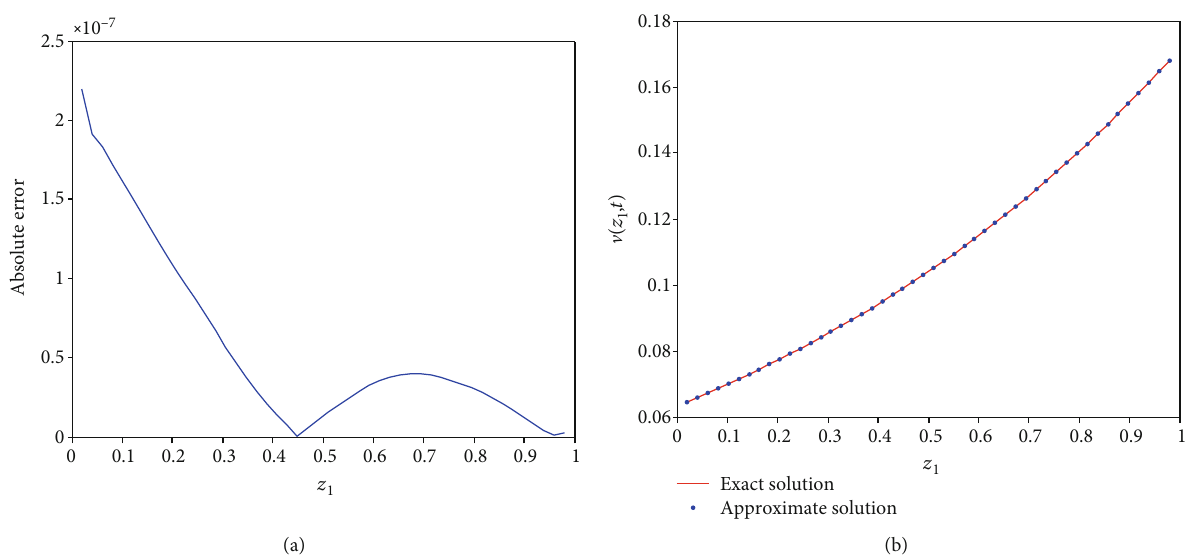
Figure 4: (a) E and (b) exact and approximate solution at α = 0 : 2 for the Problem 4. abs